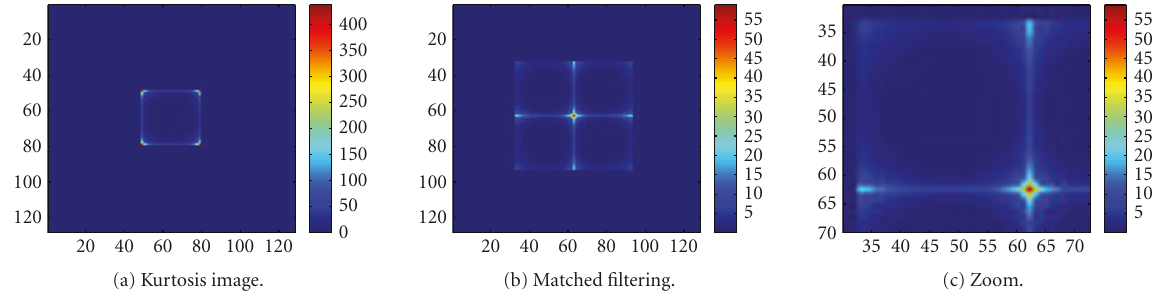
Figure 15: Matched filtering on the kurtosis image (window size 21 × 21).